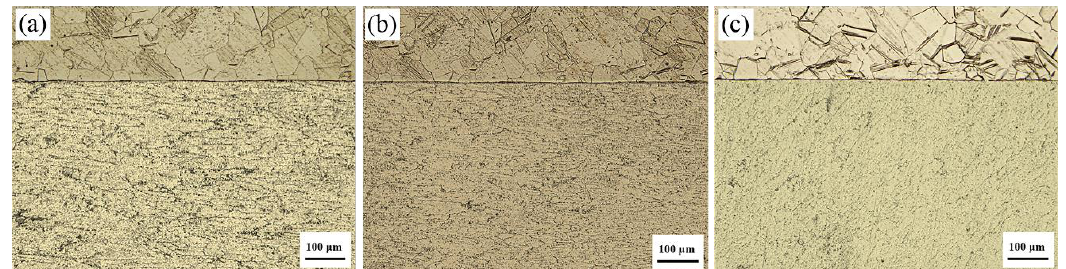
Figure 3. Optical microscope images of the interface in the Ti/Al laminated composites along ( a ) the 0° direction, ( b ) the 45° direction, ( c ) the 90° direction.